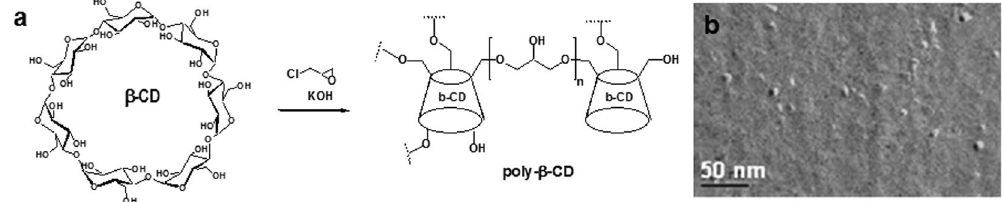
Figure 2. Nanoparticles made of pCD. ( a ) Polymerisation of β -CD with epichlorohydrin leading to the formation of cross-linked poly(2-hydroxy-1,3-propylenedioxy)-polycyclodextrin polymer (pCD) and ( b ) TEM image after freeze fracture of pCD NPs (mean size around 10